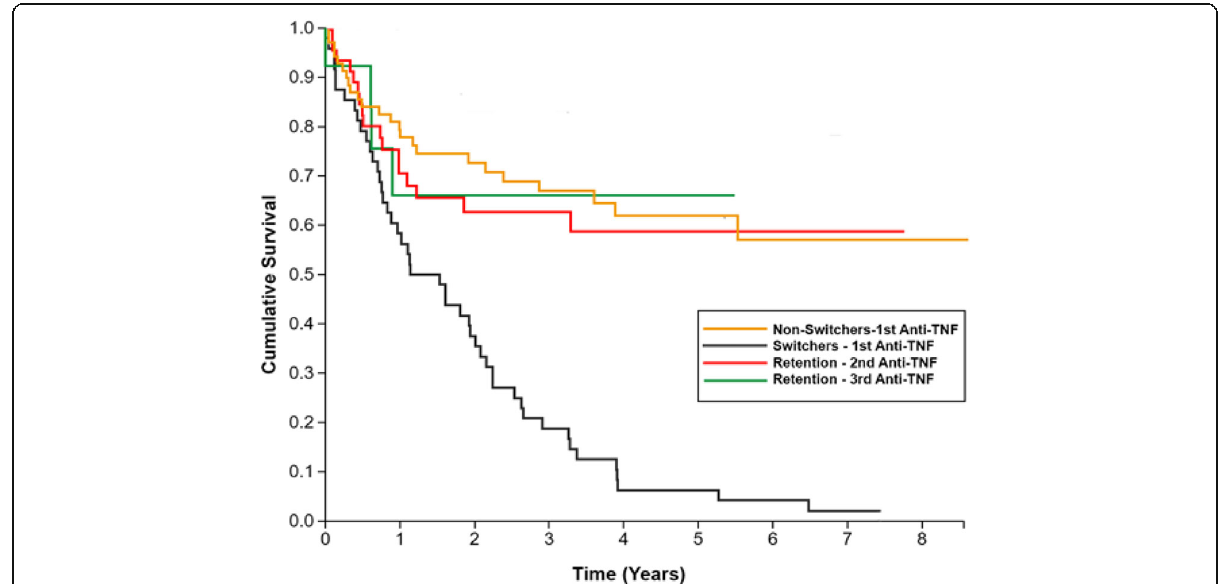
Fig. 2 Retention to therapy (Kaplan-Meier analysis); log-rank test: non-switchers vs switchers - second anti-TNF ( P = 0.007) and non-switchers vs switchers - third anti-TNF ( P =